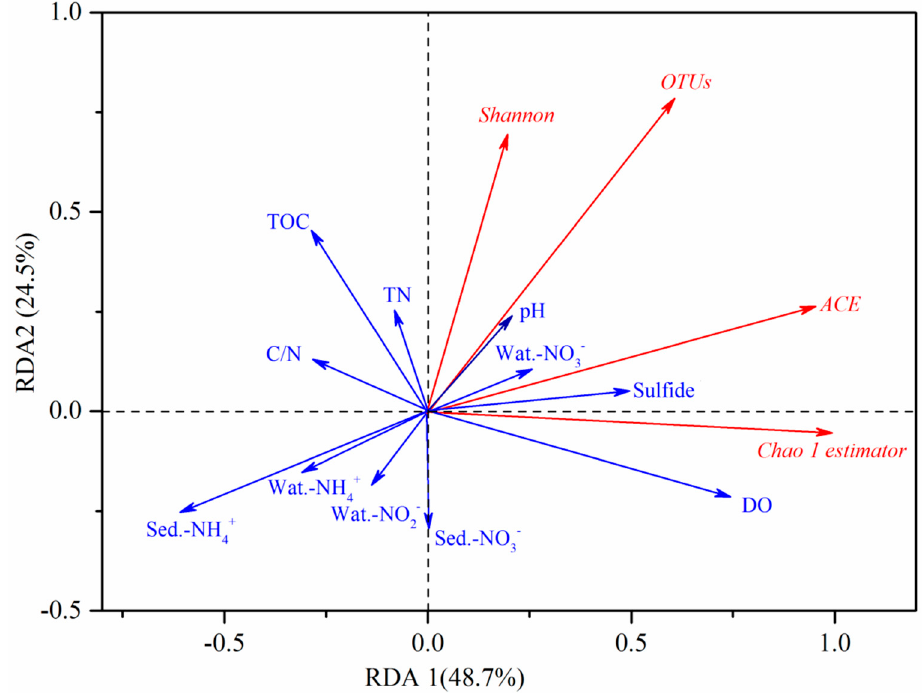
Figure 5. Redundancy analysis (RDA) compared to bacterial community richness and diversity and environmental properties. The percentages of total variation were explained by the first two axes are shown in parentheses.